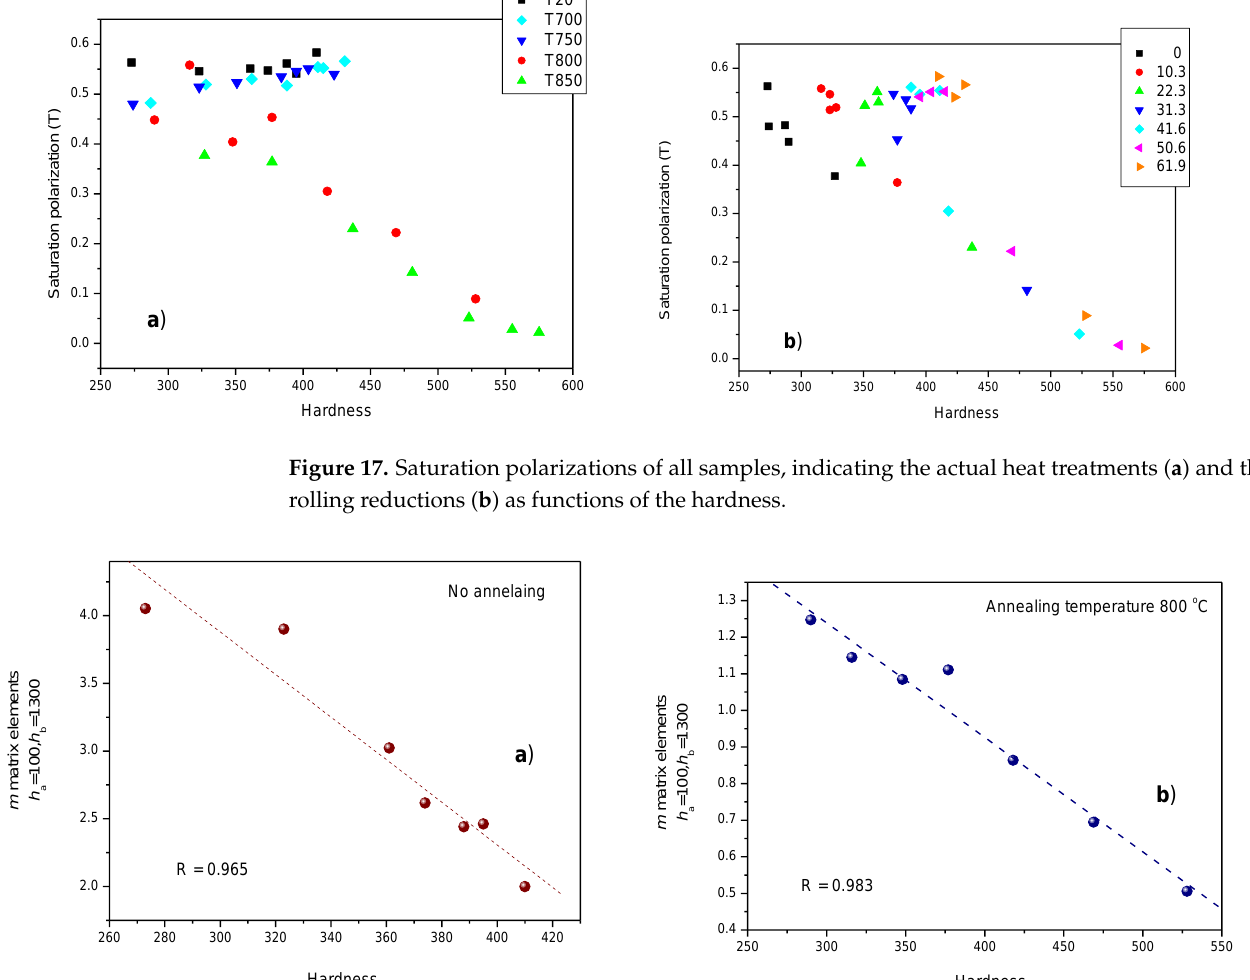
Figure 18. ( h a = 100 and h b = 1300) MAT descriptors as functions of the hardness if the two groups of samples are considered separately, as follows: cold-rolled but unannealed samples ( a ) and samples that are cold-rolled and annealed at a temperature of 800 °C ( b ).